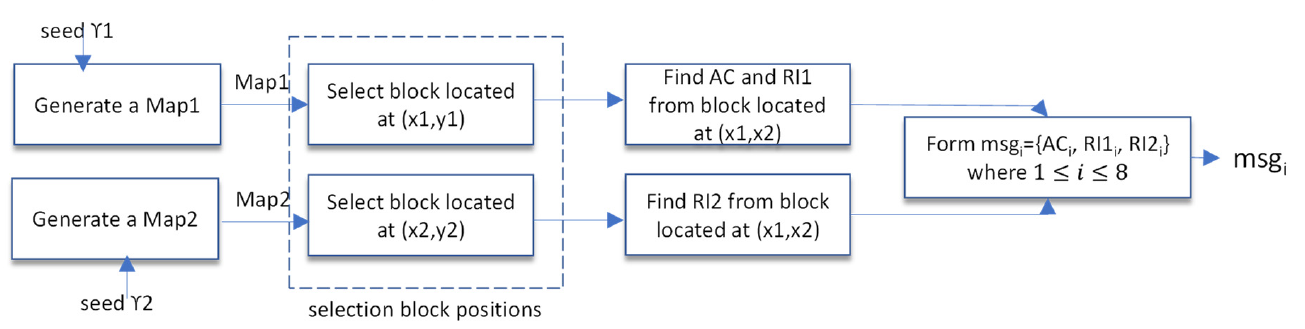
Figure 3. Watermark generation and embedding process.